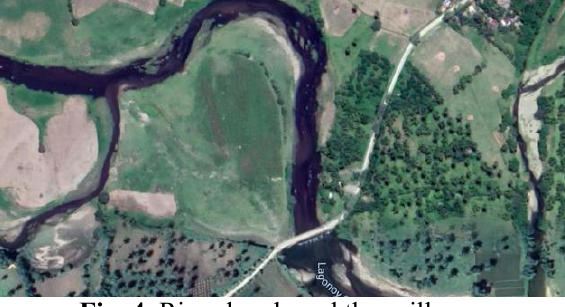
Fig. 4. River bends and the